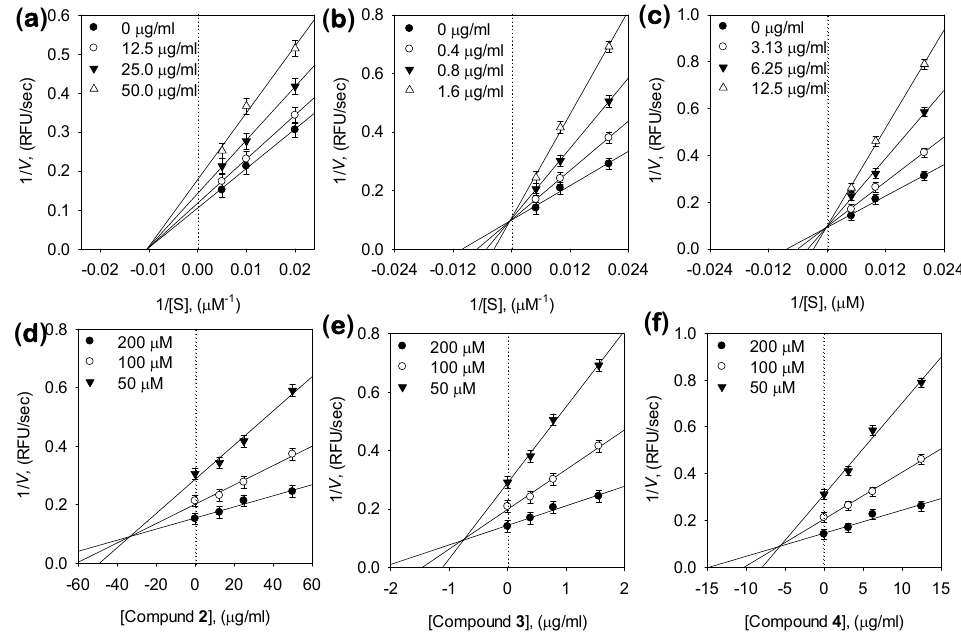
Figure 3. ( a – c ) Lineweaver-Burk plot for the inhibition of compounds ( 2 , 3 , and 4 ) on the hydrolytic activity of NA. Conditions were as followers: 0.1 mM MU-Neu5Ac, 50 mM Tris bu ff er (pH 7.5), at 38 ◦ C, ( d – f ) Dixon plots for NA inhibition of compounds ( 2 , 3 , and 4 ), in the presence of di ff erent concentrations of substrate. The graphical symbols are substrate concentrations (50 µ M, (cid:72) ; 100 µ